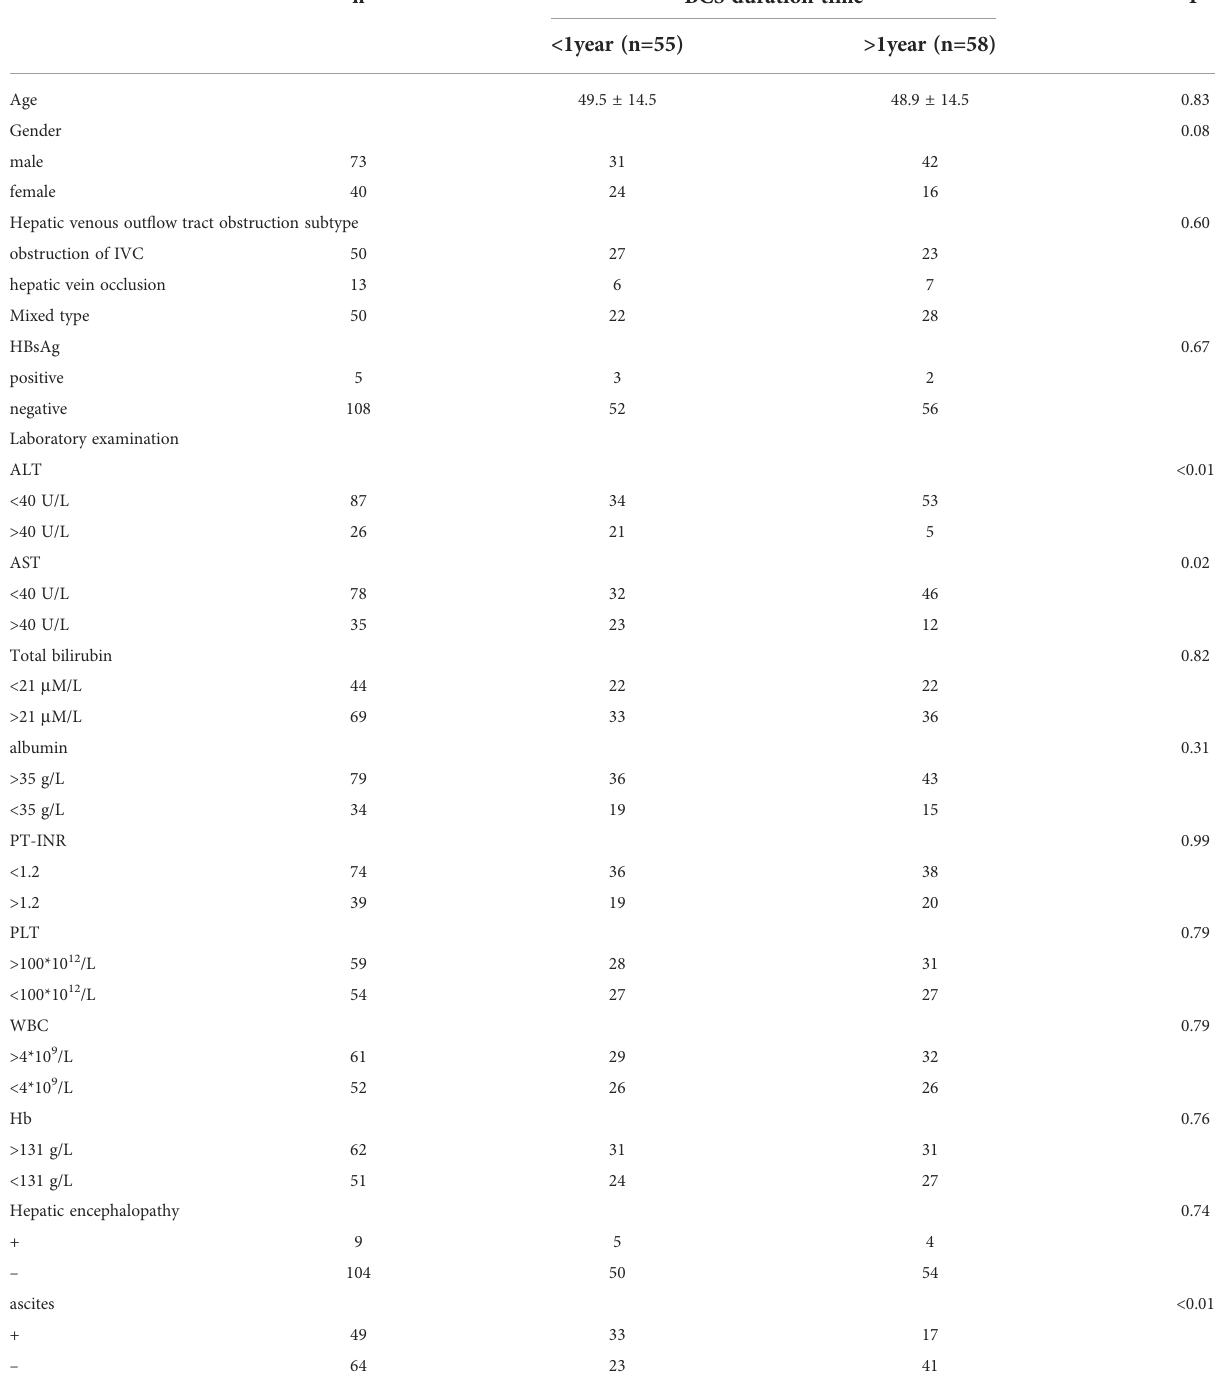
TABLE 2 Comparison of primary clinical data between patients with BCS duration time less than one year and BCS duration time more than one